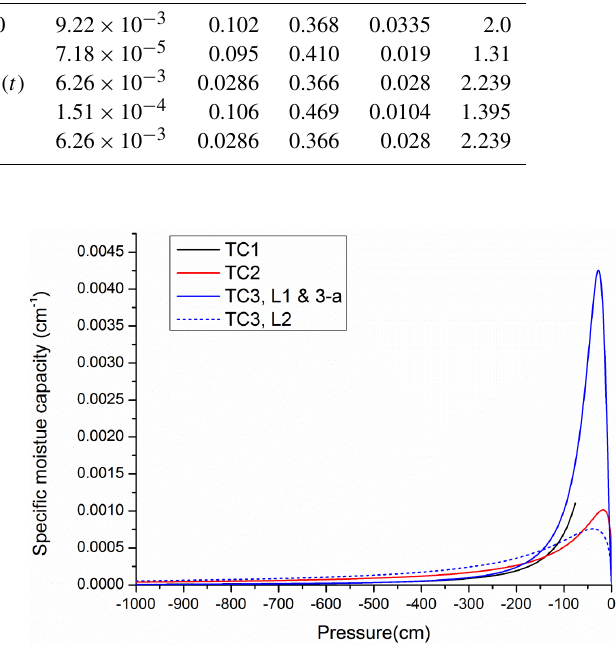
Figure 2. Water saturation as a function of the pressure for the three test cases (L1, L2 and L3 are the three layers for test case 3).